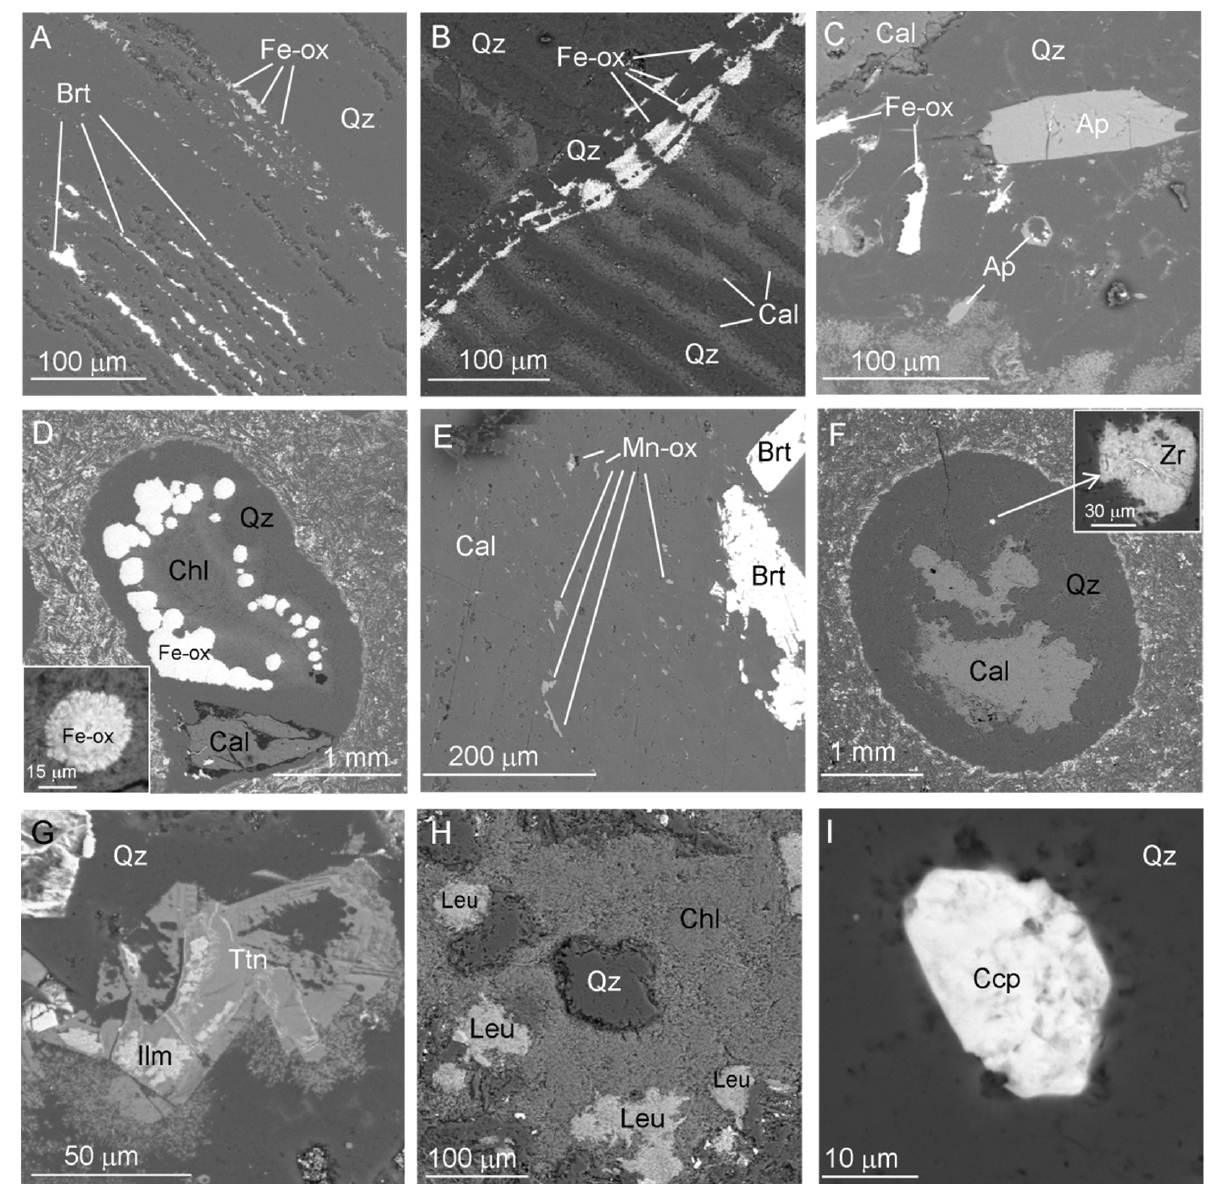
Figure 10. BSE images of microinclusions in agates: ( A ) Fe-oxides and barite (Brt) scattered along high porosity chalcedony bands in agate nodule; ( B ) a fissure filling with silica and Fe-oxides, which cross-cuts the banding agate area formed by chalcedony and calcite layers; ( C ) apatite (Ap) and Fe-oxide inclusions in silica area of agate nodule; ( D ) spherical aggregates of Fe-oxides arranged in a concentrically zoned amygdale and large calcite (Cal) crystal-filled cavity (enlarged image of spherical inclusion inserted on ( C ) from the lower left); ( E ) Mn-oxides and large barite aggregates accompanied by calcite area of agate nodule; ( F ) corroded grain of zircon (Zr) within the amygdale of quartz-calcite composition; ( G ) titanite (Ttn) and ilmenite (Ilm) aggregates surrounded by quartz (Qz) in agate nodule; ( H ) flaky leucoxene (Leu) enclosed by chlorite (Chl) in agate nodule; ( I ) grain of chalcopyrite (Ccp) in quartz (Qz) matrix within the amygdale of vesicular basalt.